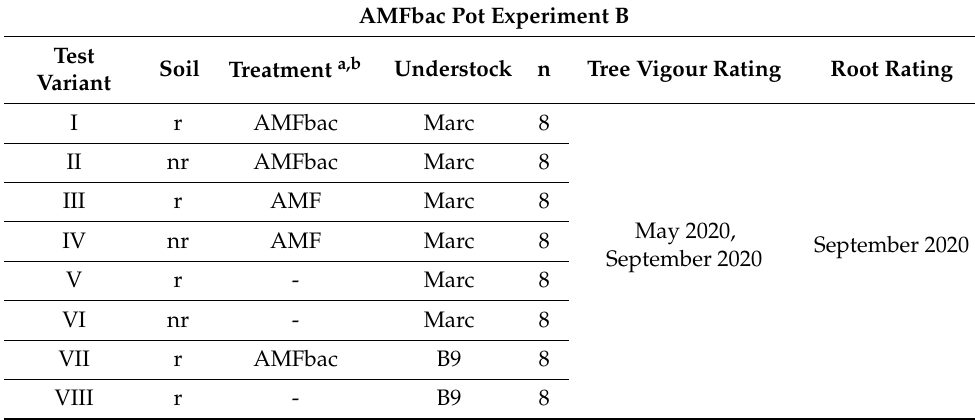
Table 5. Pot Experiment B (May to September 2020) (16 weeks) ( n = 64).